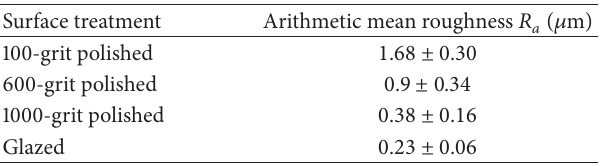
Table 1: Arithmetic mean roughness values and their standard deviations of specimens of four groups